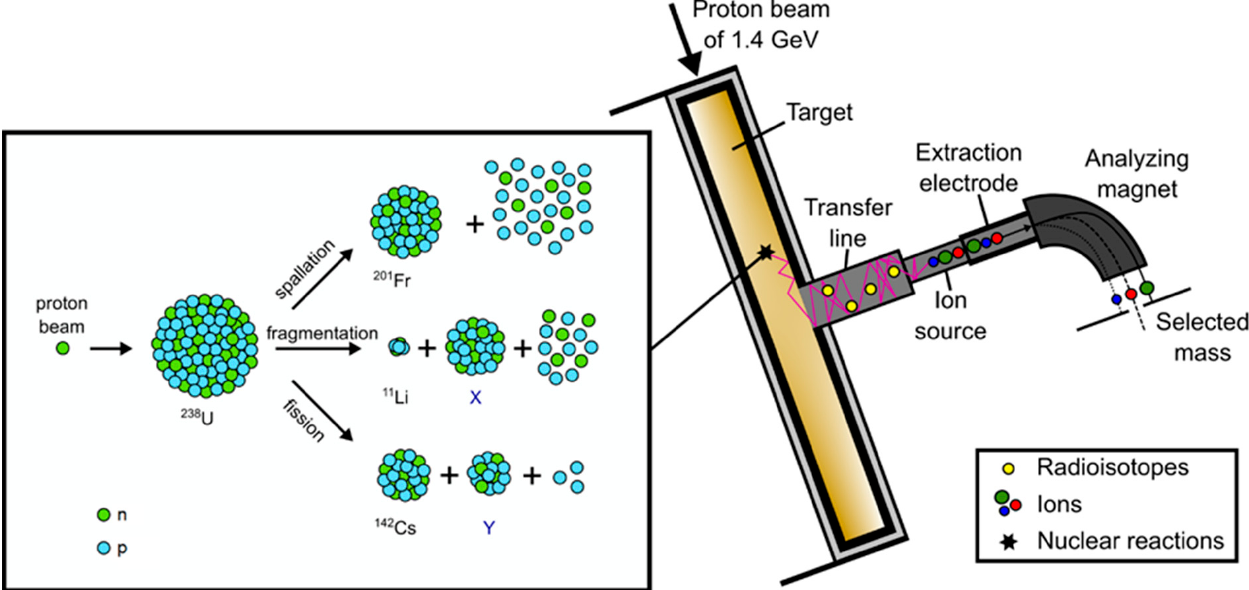
Figure 1. Schematic illustration of the ISOL method and nuclear reactions using 238 U as an example.